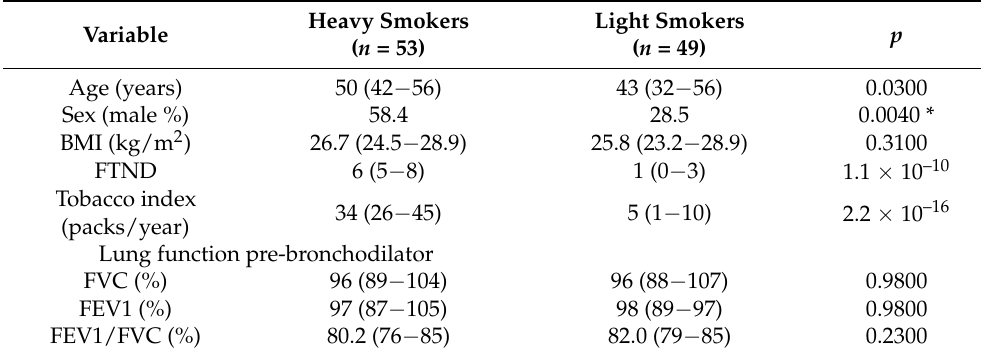
Table 2. Clinical and demographic overview of smokers.